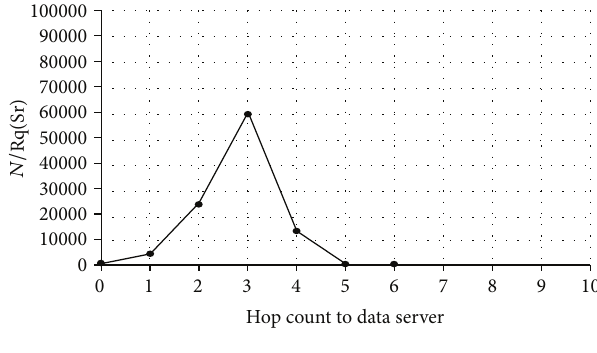
Figure 7: Dynamic adjacent list size (6) .